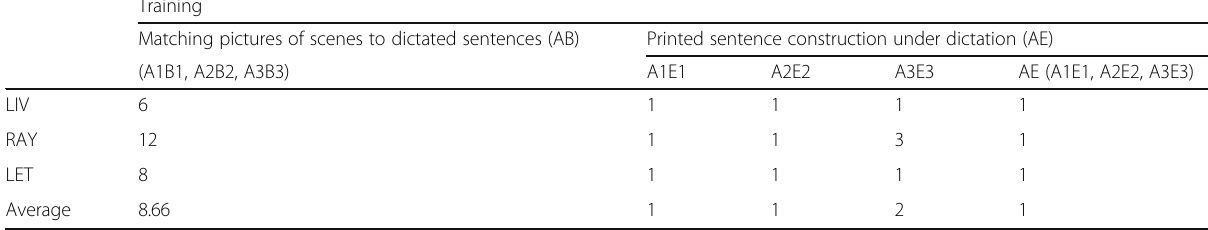
Table 3 Number of exposures to training blocks to meet the learning criterion Training